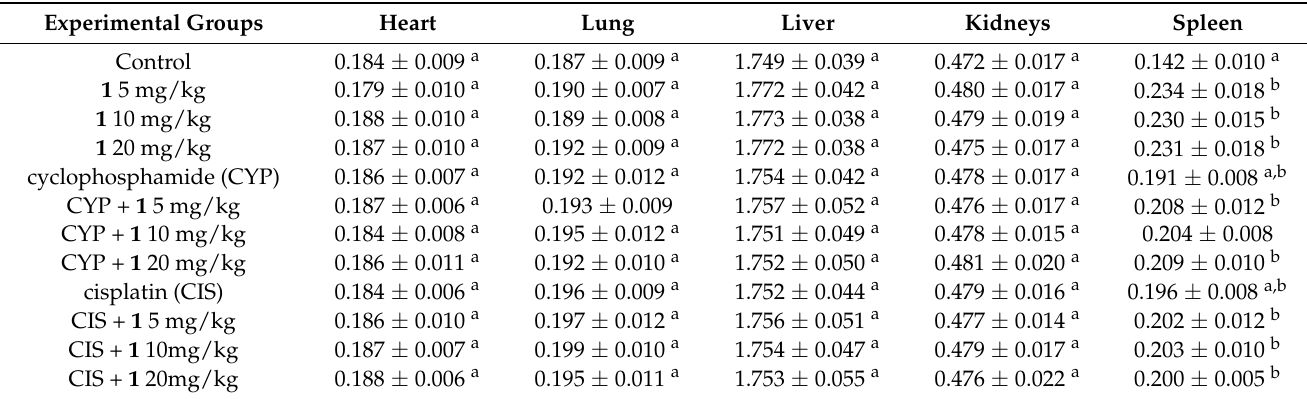
Table 2. Mean ± Standard error of the absolute weights of Swiss mice organs collected after the experimental period.